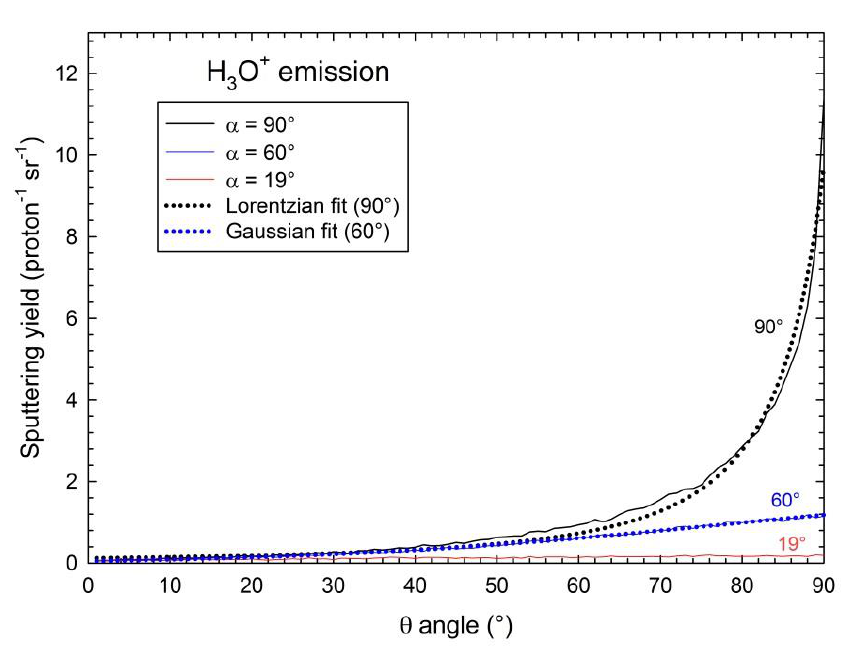
Figure 6. Angular distributions of the H 3 O + ion sputtering yield of water ice per 1-MeV p + and unit of solid angle for various incidence angles ( α = 19°, α = 60°, and α = 90°) (solid lines), as collected on the ribbon detector (Figure 8). Solid lines are least-square fits with a Lorentzian profile for α = 90° and a Gaussian profile for α = 60°.